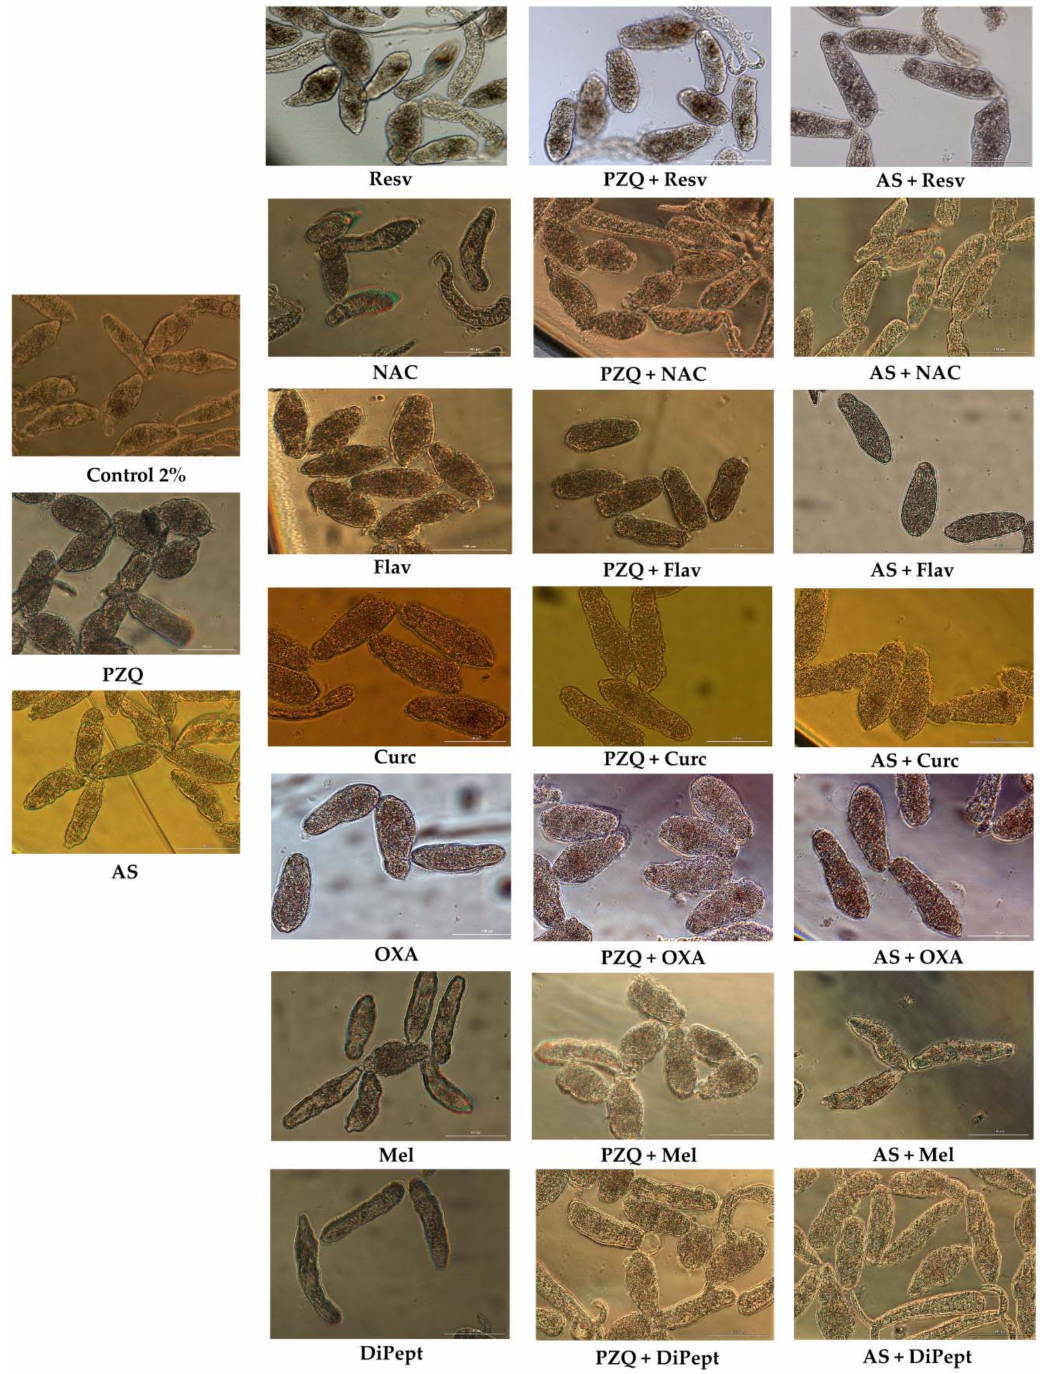
Figure 3. Representative micrographs of NTS at 72 h after exposure to combinations of praziquantel (PZQ) and artesunate (AS) with several antioxidants at 100 µ M, and 1:1 constant ratio; scale bar, 100 µ m. The antioxidants Mel and Resv enhanced antischistosomal activity of PZQ. The combination of these antioxidants, i.e., PZQ + Mel and PZQ + Resv leads to a significant decrease of NTS viability in comparison to either compound alone. In fact, the combination index demonstrated that they are slightly synergistic. The larvae incubated with combinations had similar morphological alterations induced by PZQ alone (Figure 3); nonetheless, they were less active and viability was lower than for the compounds alone (Table